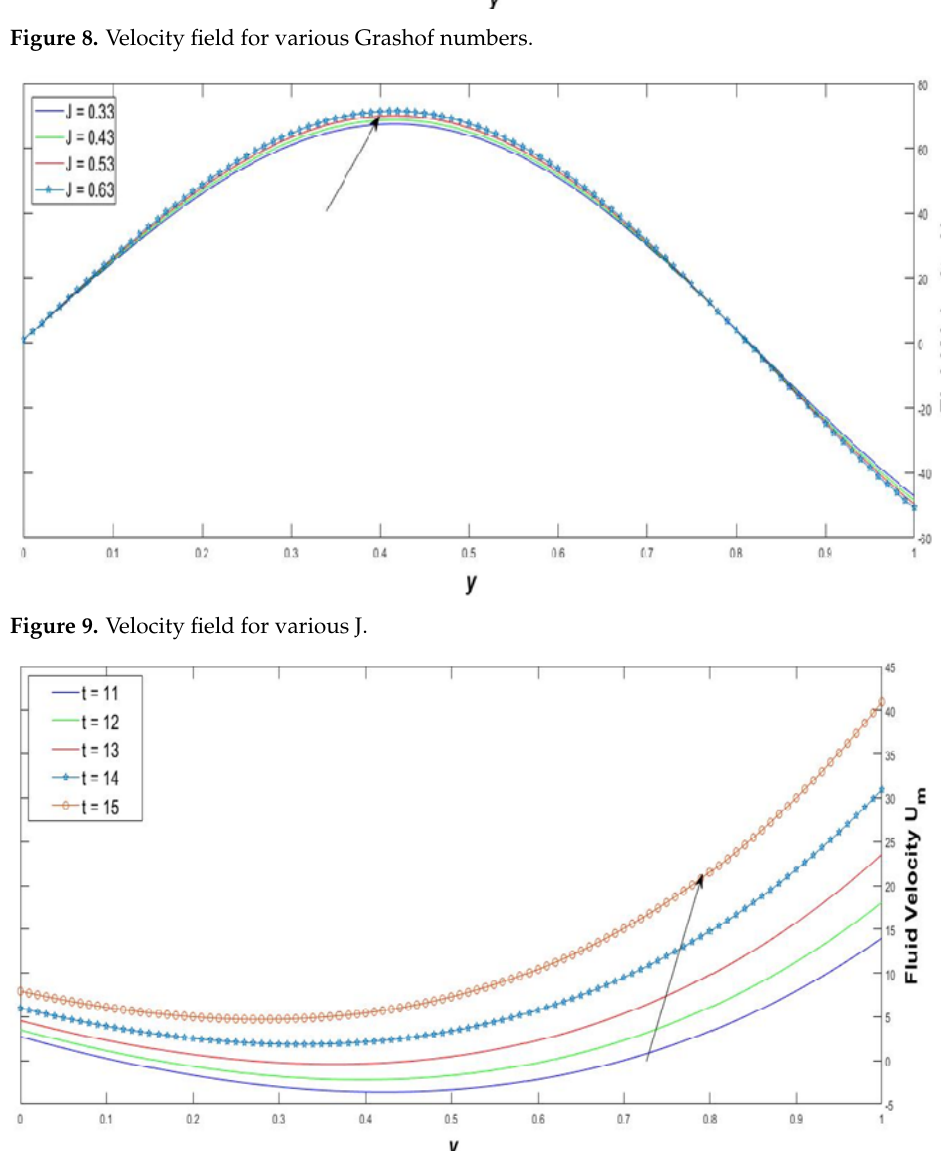
Figure 10. Velocity field for various time